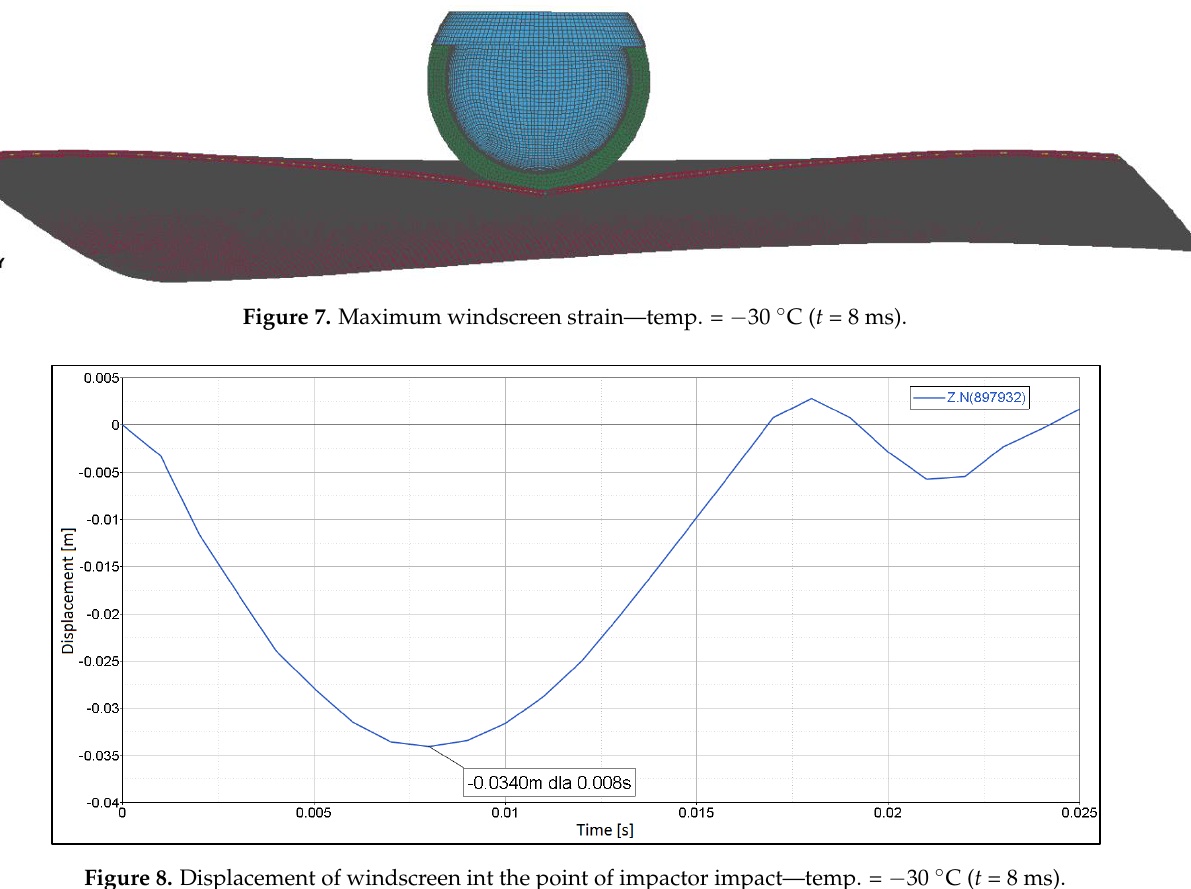
Figure 9. The maximum displacement of laminated windscreen due to head impactor impact as a function of temperature . After analysis of verified cases it has been proven that the susceptibility of laminated windscreen with a PVB membrane decreases with decreasing temperature which is in line with [38]. The windscreen displacement resulting from the head impactor impact was: 41.8 mm for temp. of +20 °C, 33.4 mm for temp. of − 20 °C. For temperature of − 30 °C the maximum displacement was 34.0 mm. The displacement value is slightly higher than for − 20 °C. It is a derivative of changes found in the PVB tension process for the temperature range of − 20 to − 30 °C, which was reflected in the locally varying glass cracking process. Figure 10 shows the nature of HIC changes obtained from the numerical simulations for the temperature ranges considered.